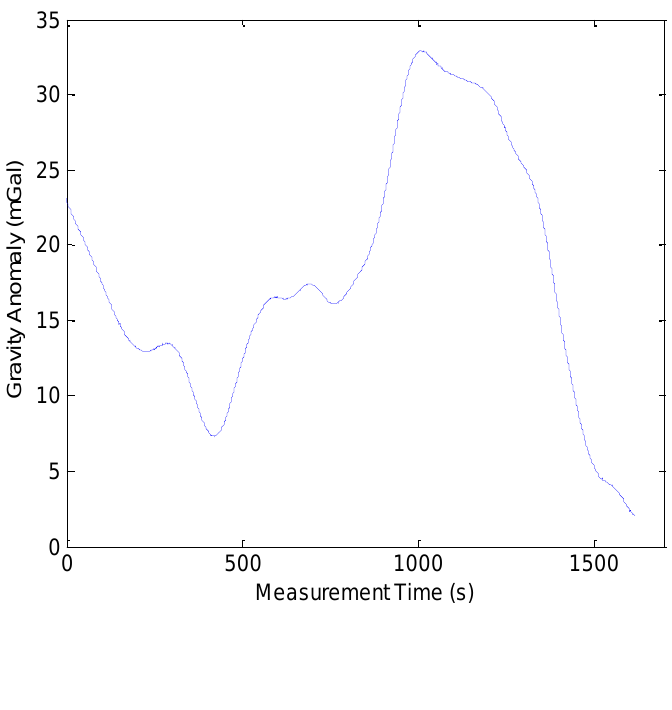
Figure 5. Gravity anomaly after low-pass